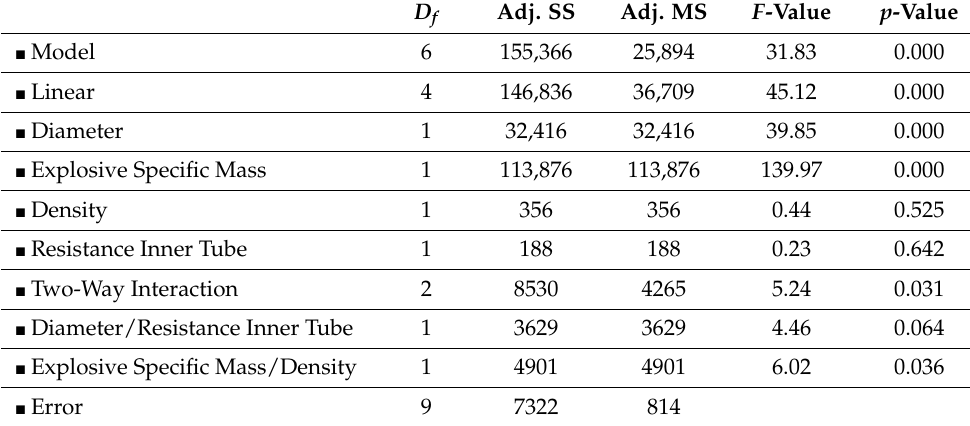
Table 5. ANOVA results using the step-by-step method: degrees of freedom ( D f ), adjusted sums of squares (Adj. SS) are measures of variation for different components of the model; adjusted mean squares (Adj. MS) measures how much variation a term explains, considering the degrees of freedom.